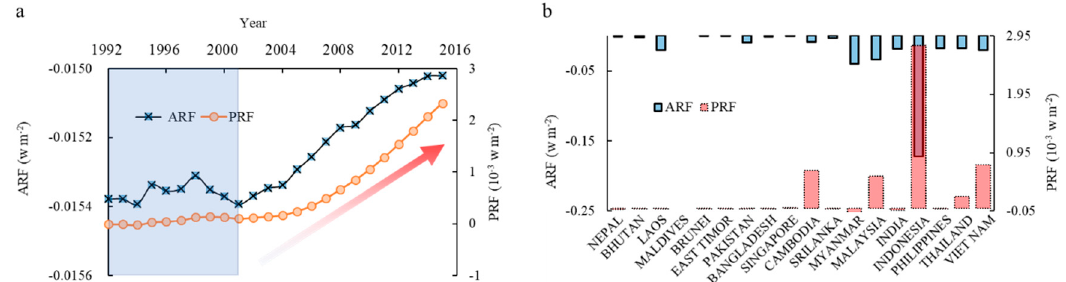
Figure 5. Actual radiative forcing (ARF) and potential radiative forcing (PRF) in South and Southeast Asia ( a ) and 18 countries ( b ).